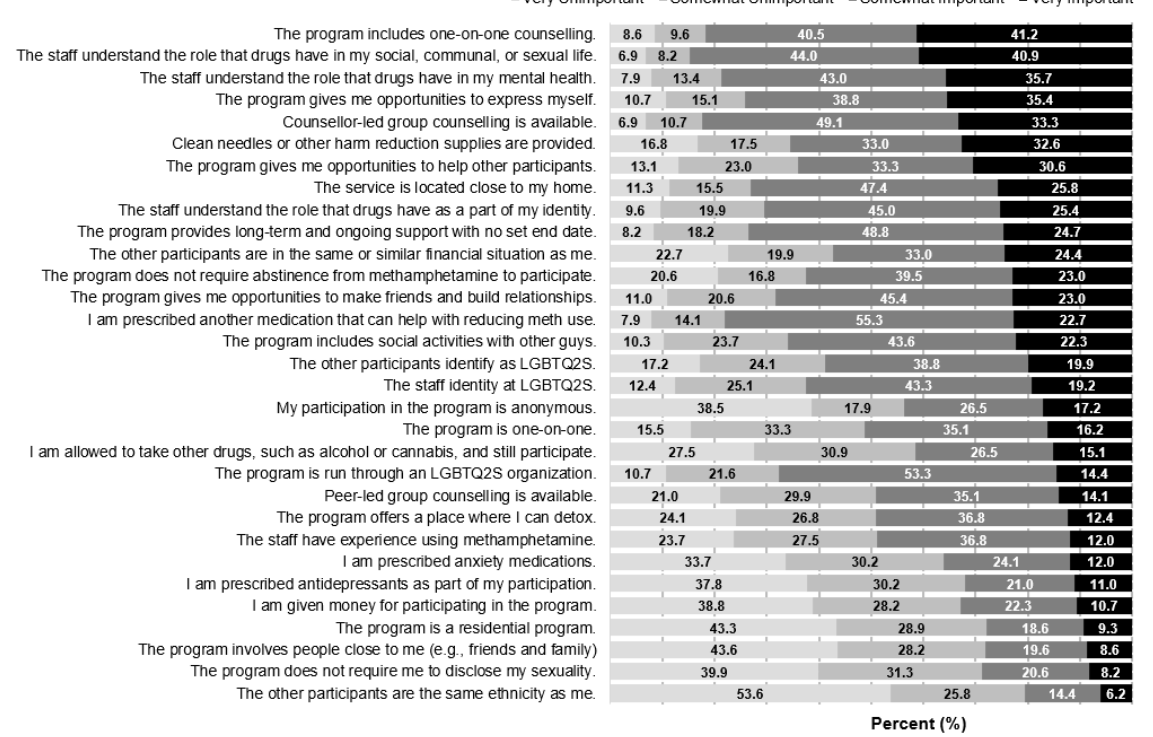
Figure 2. Participant’s Ratings of Potential Program Characteristics, ordered by Average Participant Rated Importance. Table 2. Multivariable Models Examining Associations between Program Design Preferences and SOCRATES Subscale Scores.